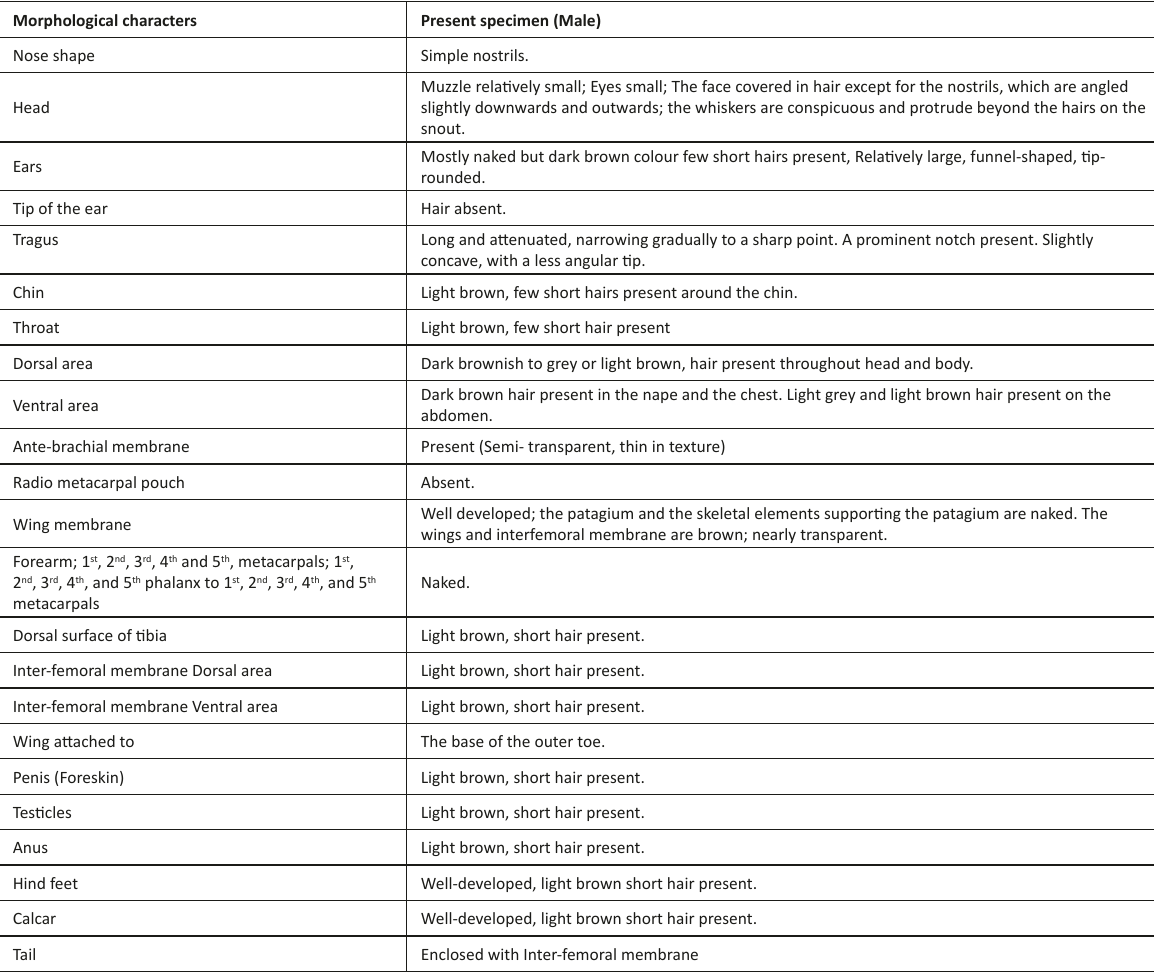
Table 2. Detailed morphological features of Kerivoula hardwickii recorded from Thoranagoda area, Sri Lanka, in this study. Morphological characters Present specimen (Male) Simple